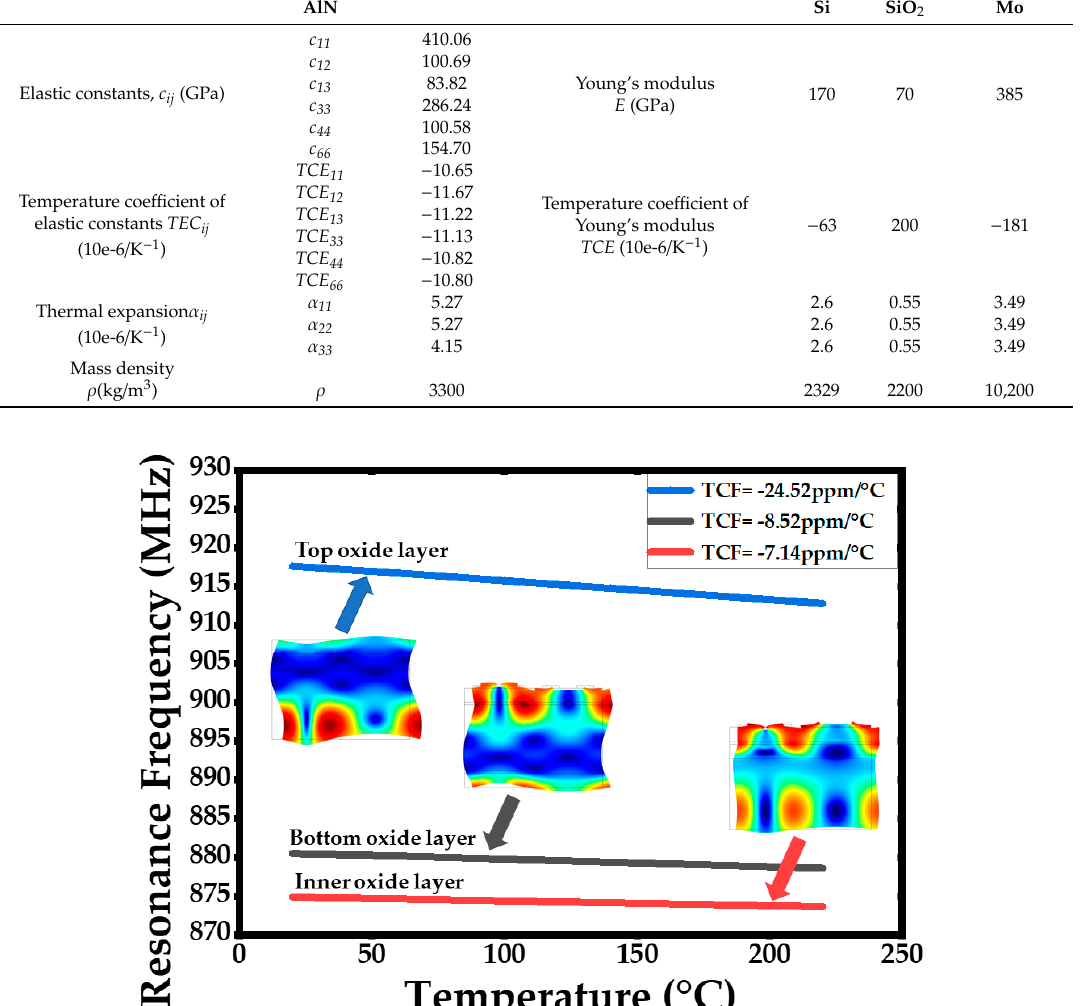
Figure 5. The simulated temperature dependent resonance frequency of acoustic wave resonator with different oxide layer position.